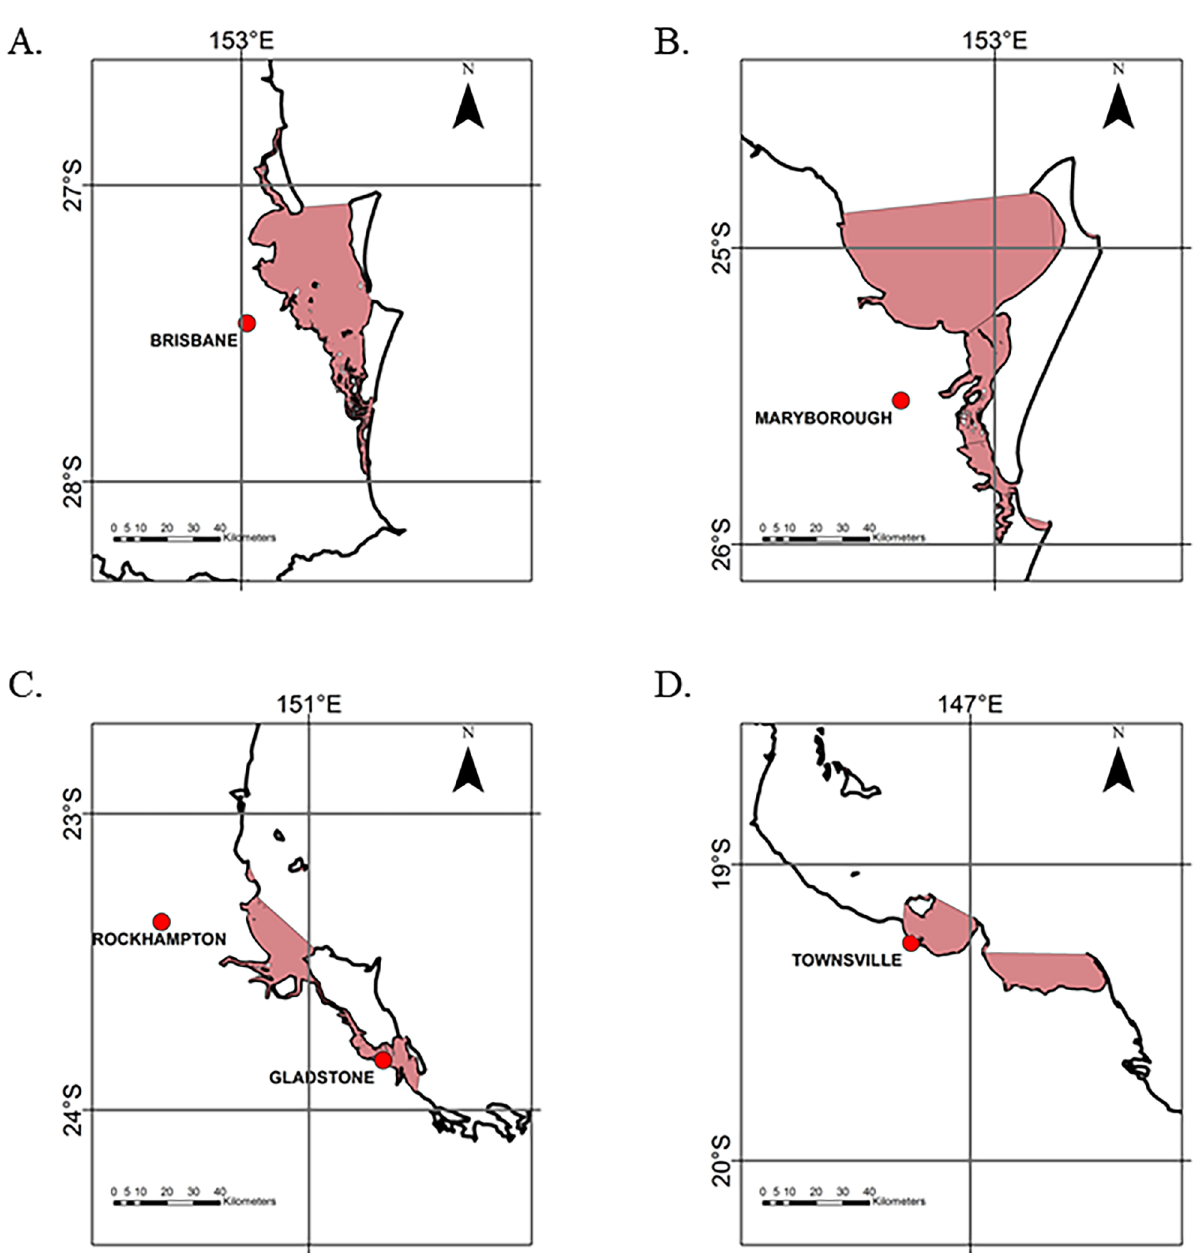
Fig 2. Embayments used for data analysis. 27˚, B. 25˚, C. 23˚, D. 19˚. Shadedarea representsembayment areas used for